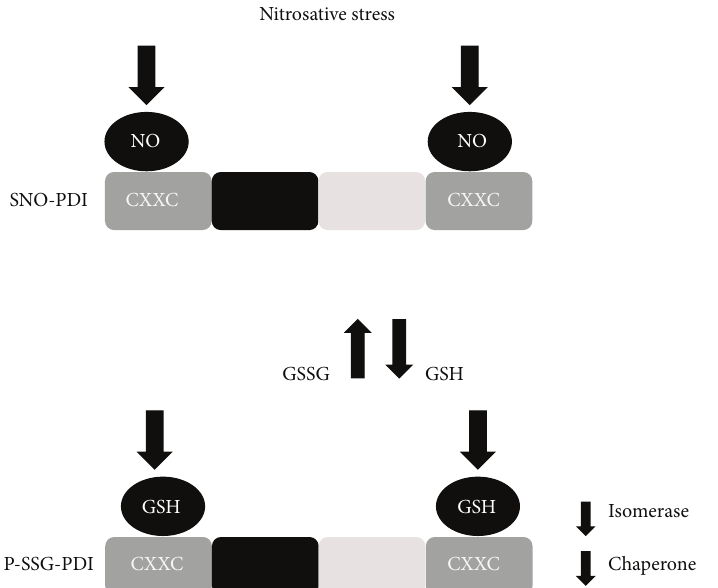
Figure 3: S-glutathionylation of PDI. Nitrosative stress from an exogenous agent (PABA/NO) increases intracellular NO and leads to the production of SNO-PDI. However, this may result in a decrease in GSSG/GSH ratio and increases in the free cellular pool of GSH. GSH then binds to the catalytic (a, a 󸀠 ) domains of PDI, resulting in S-glutathionylation (P-SSG) of its cysteine residues and attenuation of its protective isomerase and chaperone